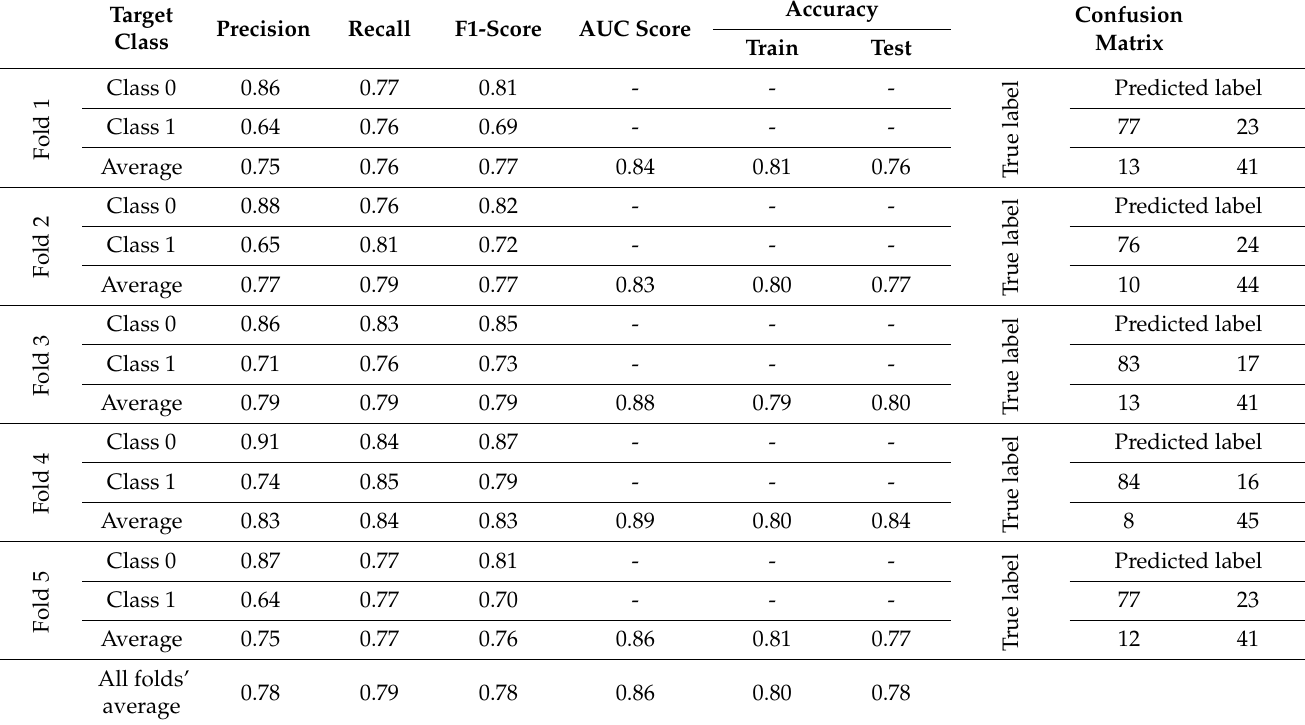
Table A3. Logistic regression’s performance for the five-fold